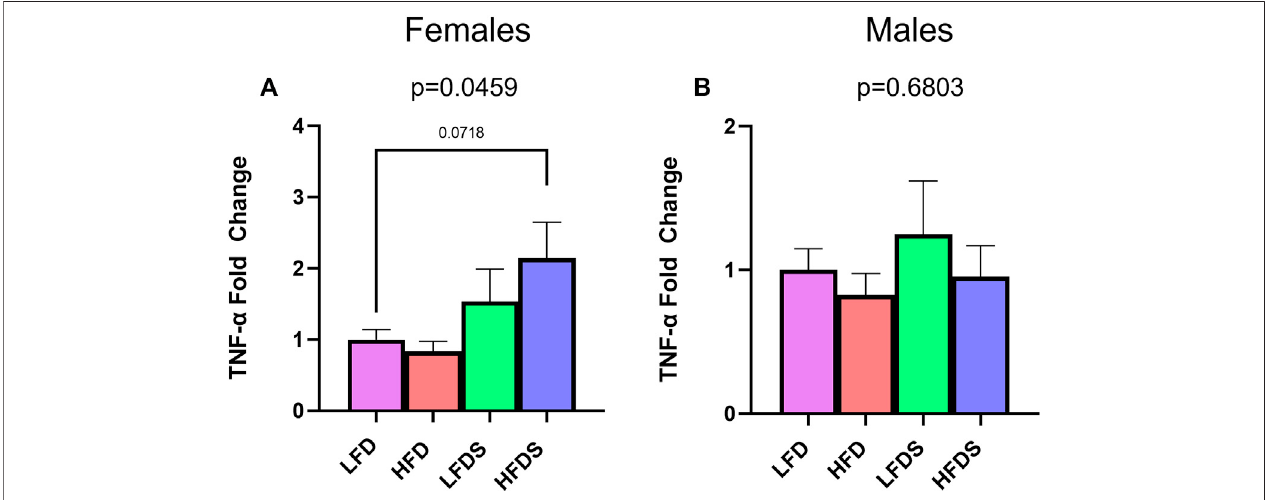
FIGURE5| TNF- α inserumoffemaleandmalerats. (A) TNF- α expressioninbloodserumfromfemaleratgroups. (B) TNF- α expressioninserumofmalerats.Data represented as mean ± SEM. Female sample sizes: LFD = 12, HFD = 7, LFDS = 8, and HFDS = 9. Male sample sizes: LFD = 7, HFD = 9, LFDS = 10, and HFDS = 9. Statistic used, One-way ANOVA with Tukey ’ s multiple comparison